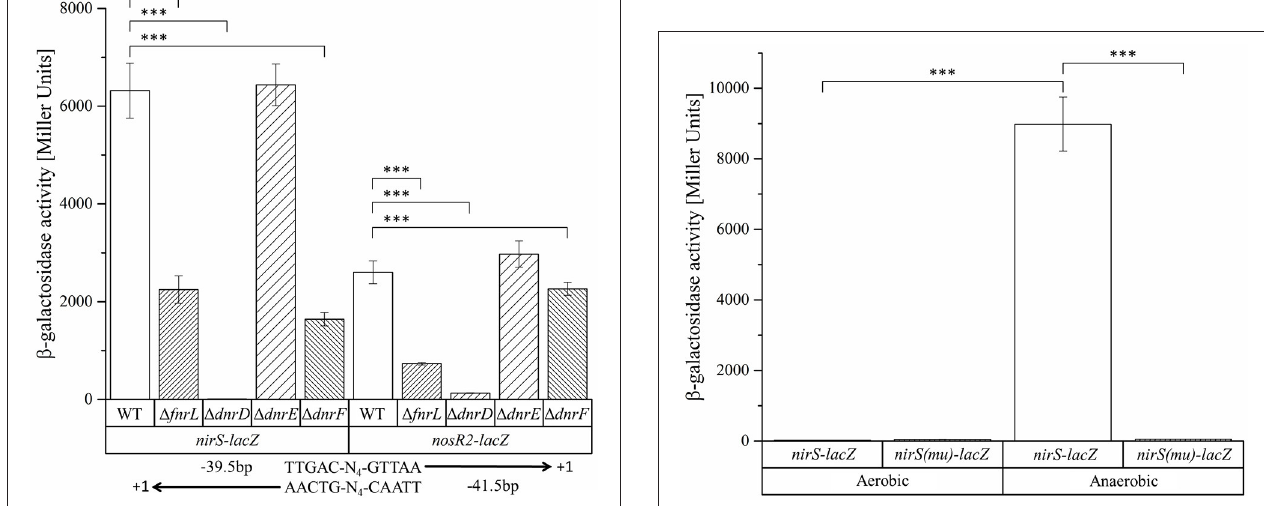
FIGURE 7 | Functional importance of the Fnr/Dnr binding site in the intergenic region of nirS and nosR2 . D. shibae wild type strains DFL12 T carrying the nirS-lacZ and nirS(mu)-lacZ reporter gene fusions were grown under aerobic and anaerobic growth conditions and β -galactosidase activities were measured in three independent replicates. The nirS-lacZ reporter gene fusion is carrying the palindromic sequence 5 ′ -TTAAC-N 4 -GTCAA-3 ′ of the Fnr/Dnr binding site. The binding sequence was mutated to 5 ′ - GC AAC-N 4 -GTC GC -3 ′ in the nirS(mu)-lacZ reporter gene fusion. Error bars represent the observed standard deviation. P -values were determined using ANOVA and the Tukey-test (Tukey, 1949). The symbol *** indicate P -values smaller or equal to